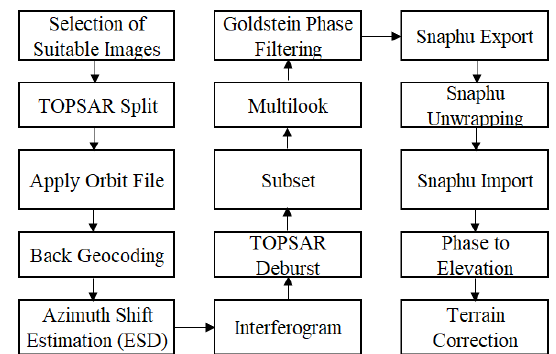
Figure 6 . DTM generation workflow using Sentinel-1